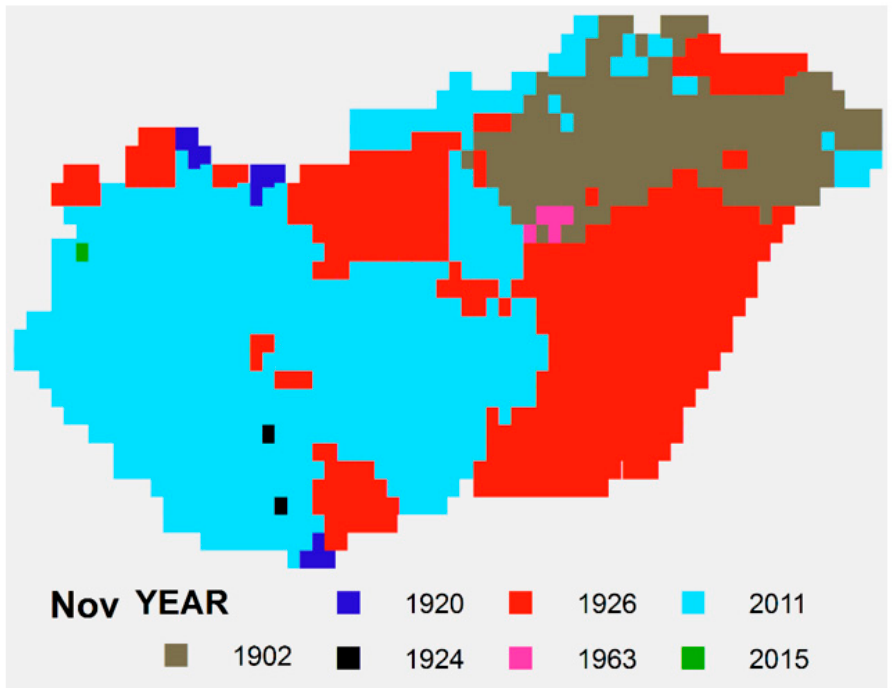
Figure A19. November: Year of maximum SPTI values, 1871–2020.